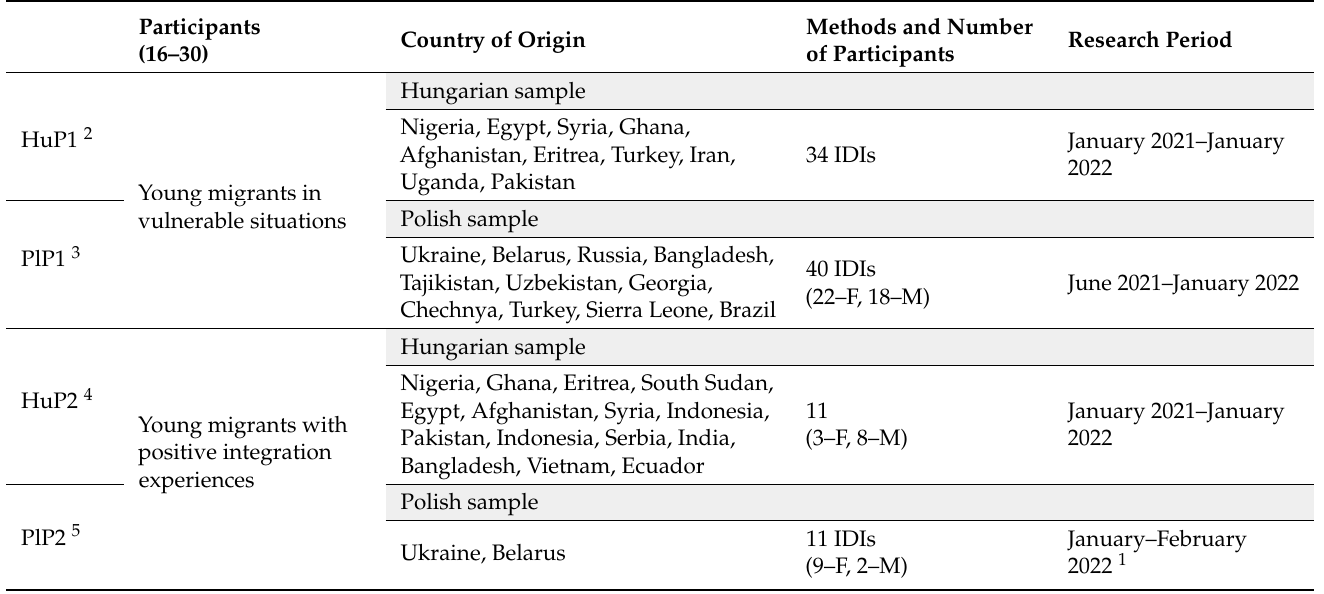
Table A1. Characteristics of the Samples in Hungary and